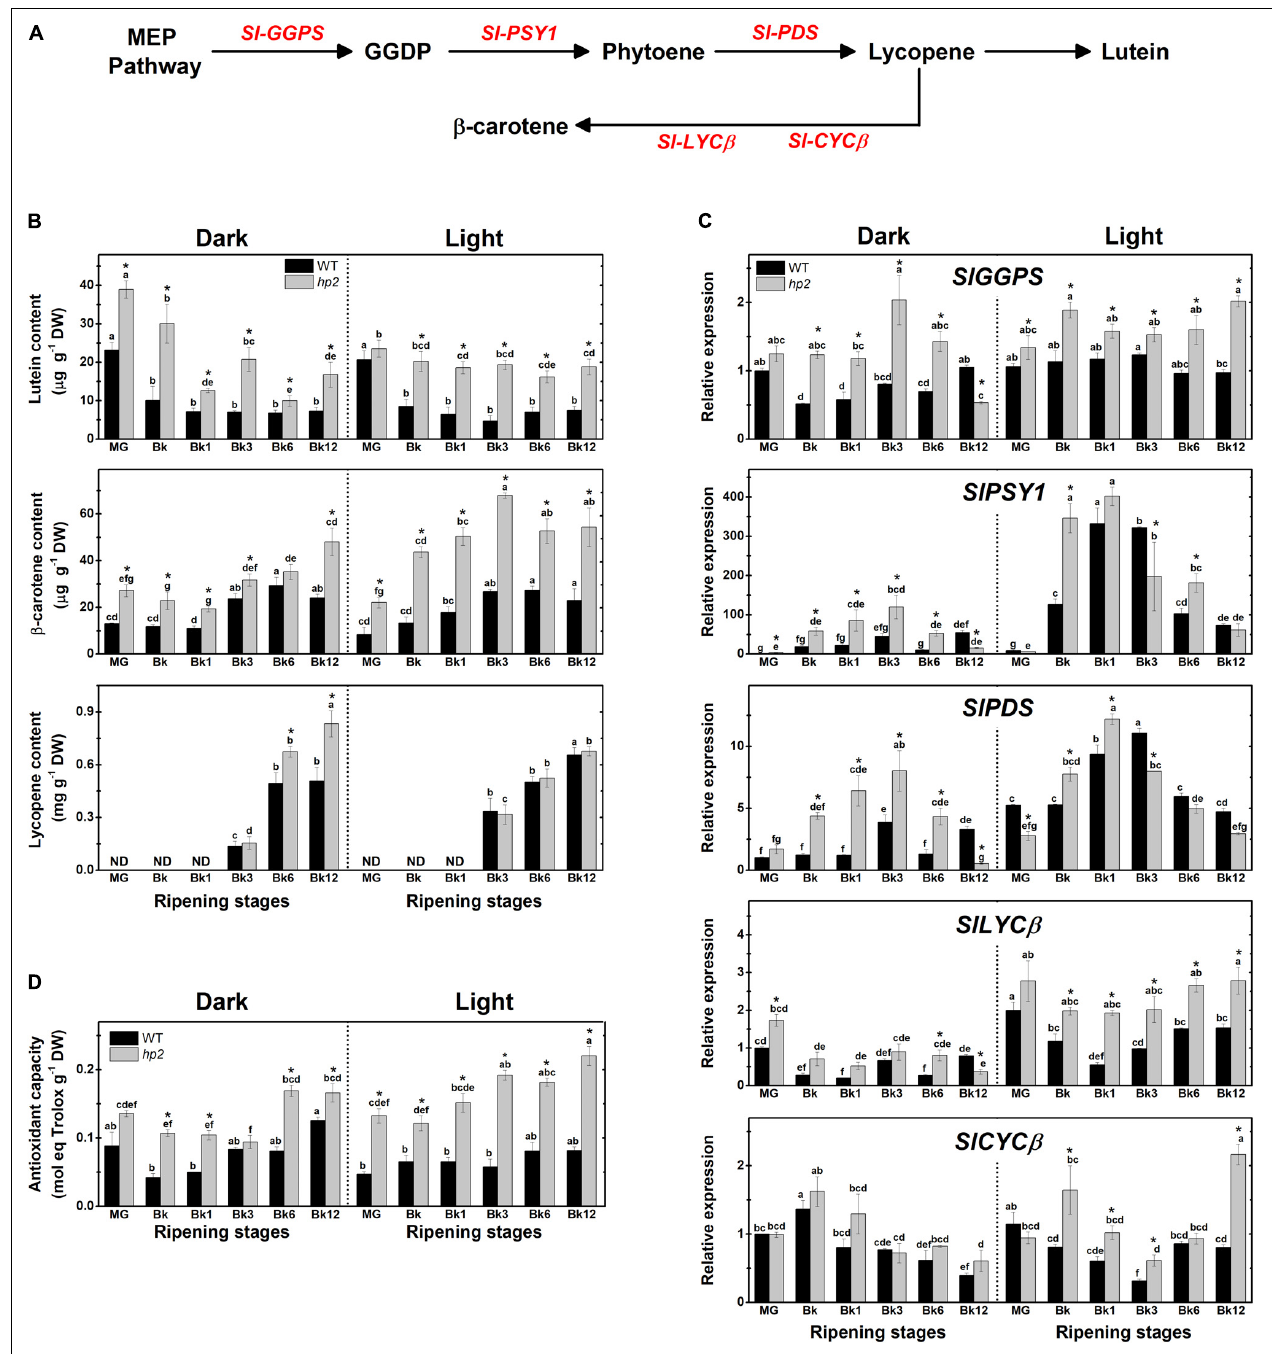
FIGURE 1 | Loss of Sl-DET1/HP2 function promotes tomato fruit carotenoid biosynthesis and antioxidant capacity in both dark- and light-ripened fruits. Wild-type (WT) and high pigment-2 ( hp2 ) fruits harvested at mature green (MG) stage were left to ripen under constant light (L) or dark (D) conditions. Pericarp samples were harvested at MG (2 days after the beginning of treatment), breaker (Bk), Bk1 (1 day after Bk), Bk3, Bk6, and Bk12 stages. (A) Schematic representation of carotenoid biosynthetic pathway in tomato. Intermediate reactions are omitted. (B) Lutein, β -carotene and lycopene content in pericarp tissues. (C) Relative mRNA levels of carotenoid biosynthesis genes. Mean relative expression was normalized against wild-type (WT) samples at mature green (MG) stage under dark conditions. (D) Trolox equivalent antioxidant capacity (TEAC) content in lipophilic extracts. Data are means ( ± SE) of at least three biological replicates. Different letters indicate statistically significant differences (Tukey’s test, p < 0.05) within each genotype. Asterisks indicate statistically significant differences (Student’s t -test, p < 0.05) between genotypes. MEP, Methylerythritol 4-phosphate; GGDP, Geranylgeranyl diphosphate; GGPS, GGDP synthase; PSY, Phytoene synthase; PDS, Phytoene desaturase; LCY β , Chloroplast-specific β -lycopene cyclase; CYC β , Chromoplast-specific β -lycopene cyclase.